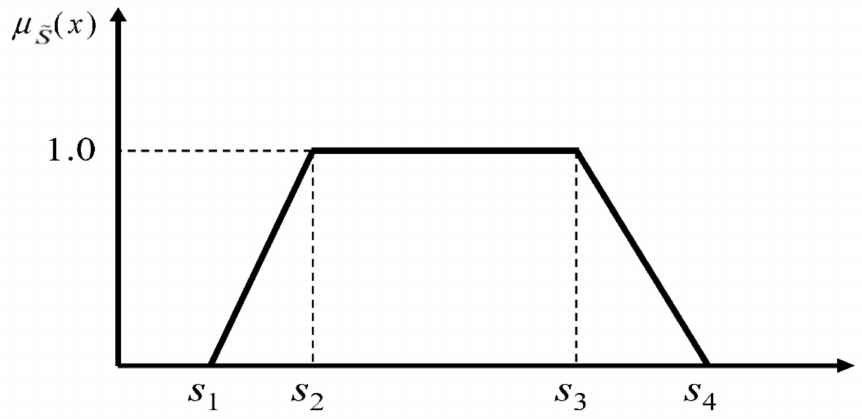
Figure 1. Trapezoidal fuzzy number of (cid:101) S